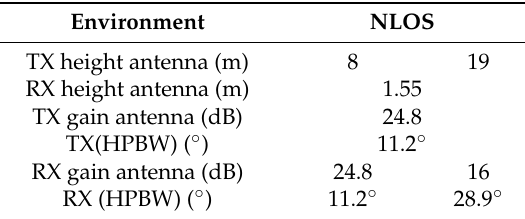
Table 1. Measurements between the sender (TX) and the receiver (RX) with a frequency of 38 GHz. Environment